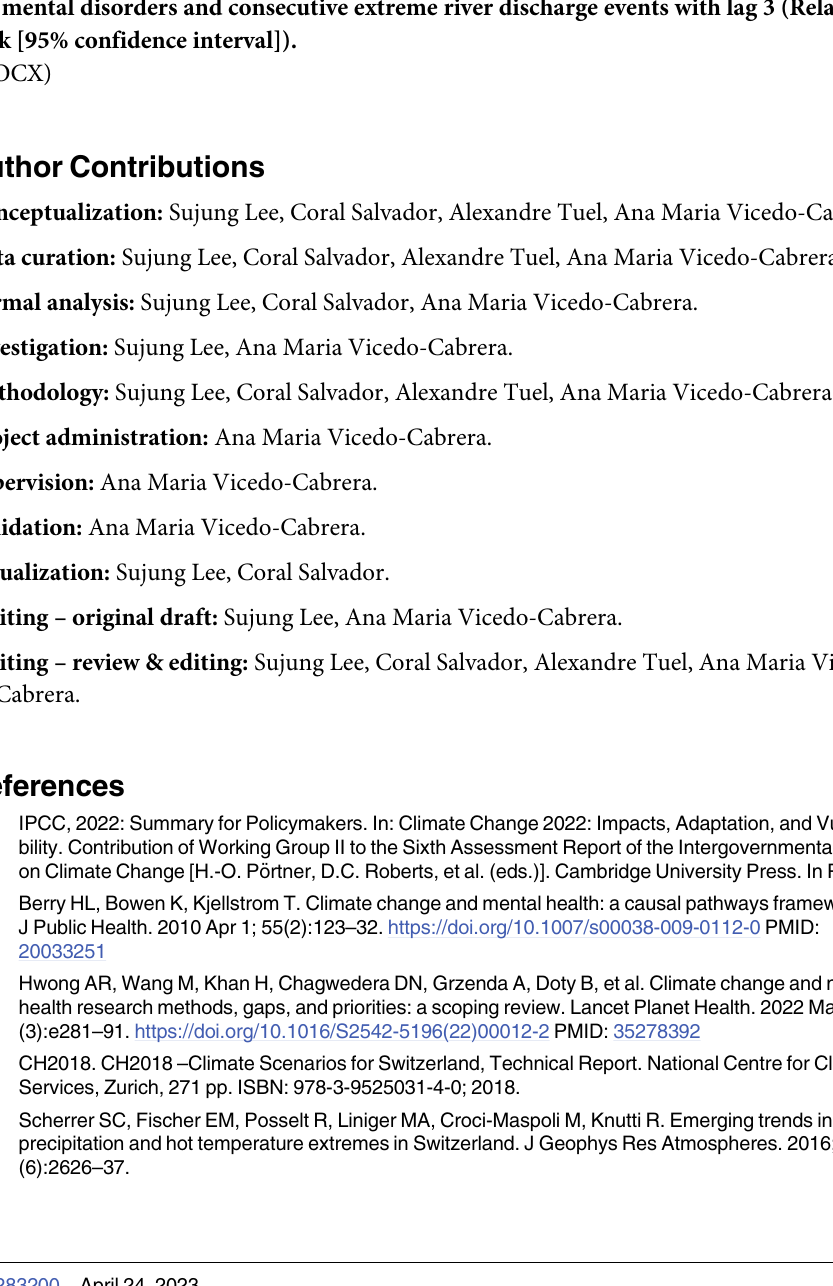
S1 Table. Significance levels obtained in A) the Wald test and B) Cochran Q-test to deter- mine the implication of sex, age, diagnosis, season, and geographical unit (city) as explana- tory factors of heterogeneity between results. S2 Table. Pooled association estimates of seasonal analysis between hospital admissions for mental disorders and PP.2 PP.3, PP.4, and PEP90.2 events with lag 3 (Relative Risk [95% confidence interval]). S3 Table. Pooled association estimates of sensitivity analysis between hospital admissions for mental disorders and consecutive extreme river discharge events with lag 3 (Relative Risk [95% confidence